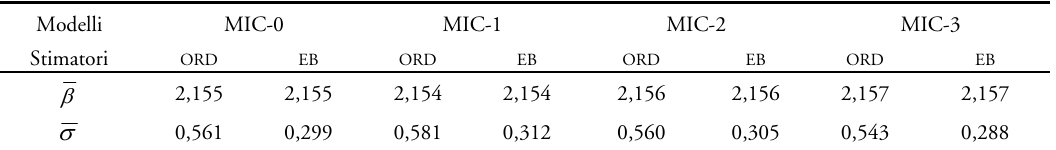
Scarto quadratico medio (cid:86) dei valori dello stimatore ordinario ed empirico-bayesiano (cid:69) dei modelli MIC dell'intercetta j 0 Modelli